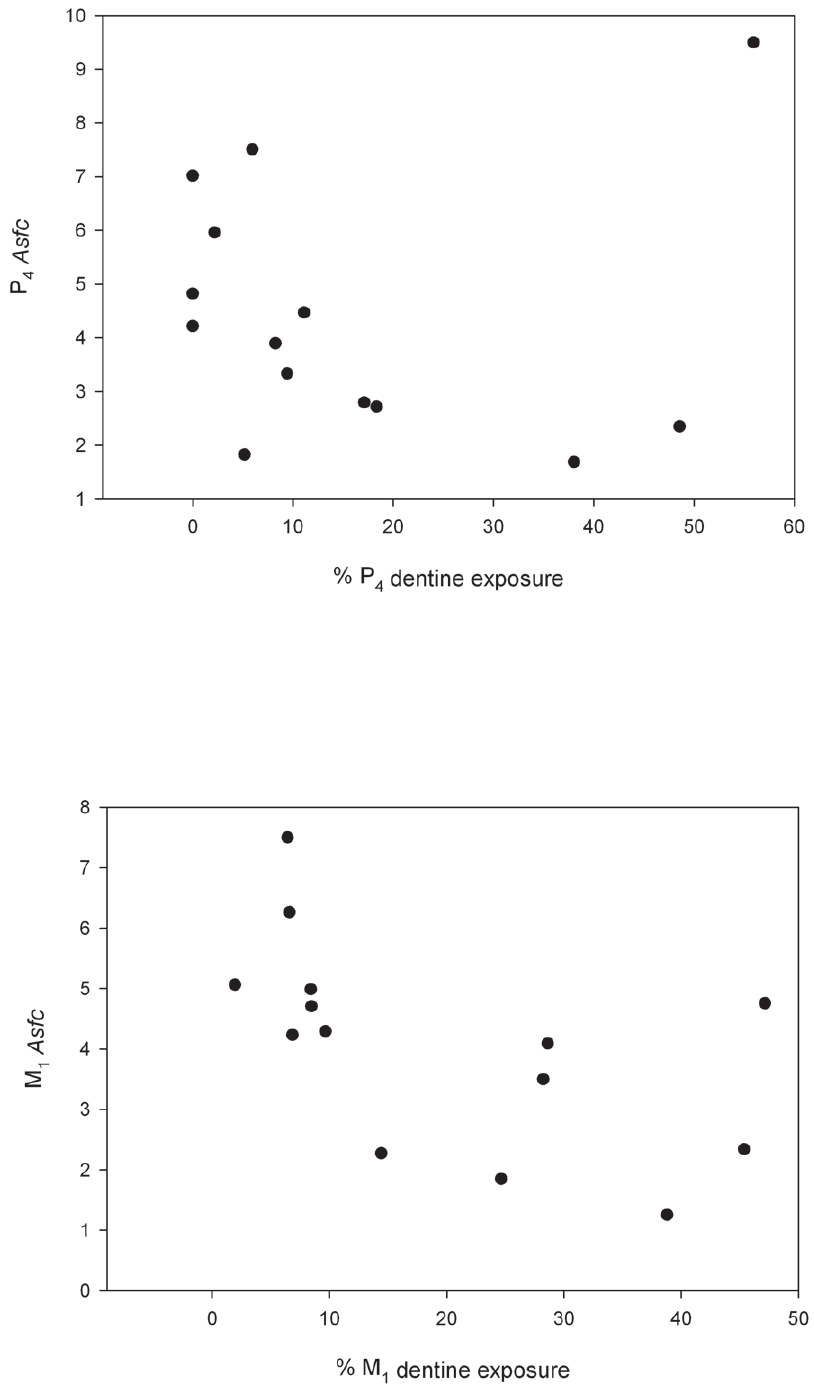
Figure 5. Relationship of microwear complexity to state of wear on P 4 ( P =0.253 by Spearman’s r ) and M 1 ( P =0.0081) in Cercocebus atys . Under an experimentwise a =0.00625, none of the microwear texture indices covaries significantly with magnitude of attrition.